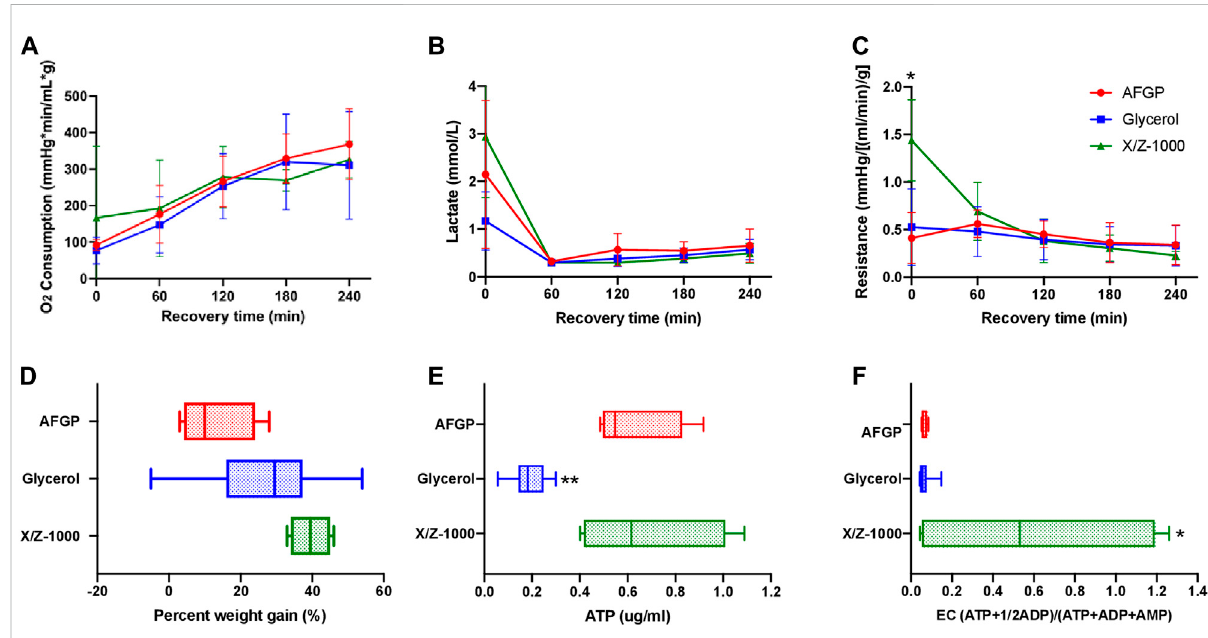
FIGURE 3 Perfusion metrics comparing rat livers partially frozen at – 15 ° C with AFGP ( n = 4) or with X/Z-1000 ice modulators ( n = 4) versus 12% glycerol control ( n = 13), with 4 h of recovery during SNMP. There was higher t = 0 resistance and energy charge in X/Z-1000 livers, and lower ATP levels in glycerol livers. (A) Oxygen consumption, de fi ned as out fl ow oxygen minus in fl ow oxygen, adjusted for fl ow rate and liver weight, (B) portal vein lactate, (C) vascular resistance, de fi ned as the perfusion pressure in the PV divided by the fl ow rate and adjusted for liver weight after procurement, (D) percent weight gain, de fi ned as percentage increase of liver weight at the end of recovery compared to liver weight after procurement, (E) ATP, (F) energycharge.Starsdenotestatisticalsigni fi cance(two-wayANOVA,followedbyTukey ’ s posthoc testfor (A – C) ,one-way ANOVA,followedbyTukey ’ s posthoc testfor (D – F) :*0.01 < p < 0.05;**0.001 < p < 0.01.Errorbarsrepresentstandarddeviation.Boxes:medianwith interquartile range. Whiskers: min to